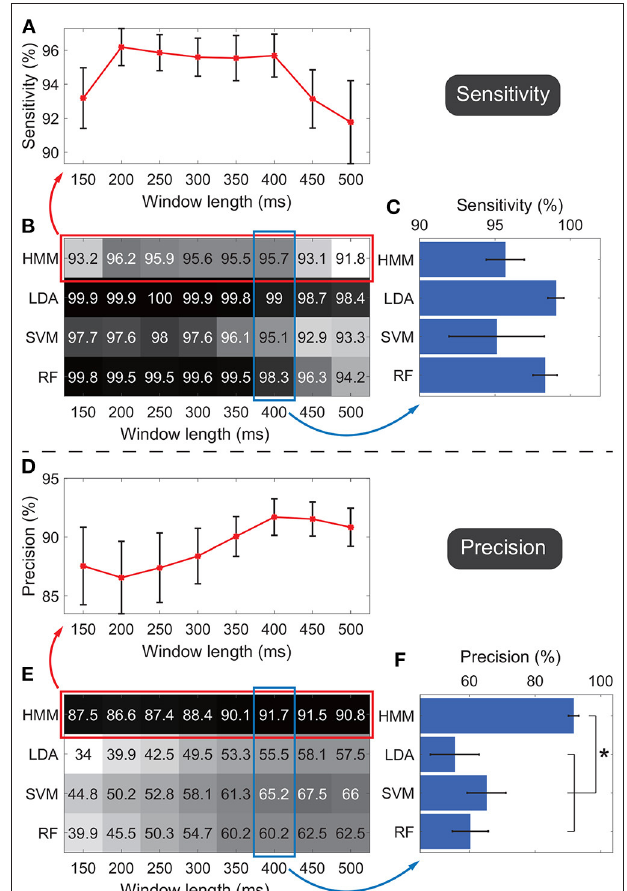
FIGURE 6 | Sensitivities and precisions under different window lengths and different classifiers. Panels (A–C) indicate the evaluations of sensitivities. Panels (D–F) indicate the evaluations of precisions. Panels (B,E) show the average sensitivity and precision across subjects respectively, where the rows in the matrix indicate results of the four classifiers and the columns indicate the results under different window lengths. Darker color indicates a higher value. Panels (A,D) further visualize performances of HMM with standard errors across subjects, where all window lengths were used. Panels (C,F) further visualize performances of four classifiers with standard errors across subjects, where only the 400-ms window was adopted. * p <